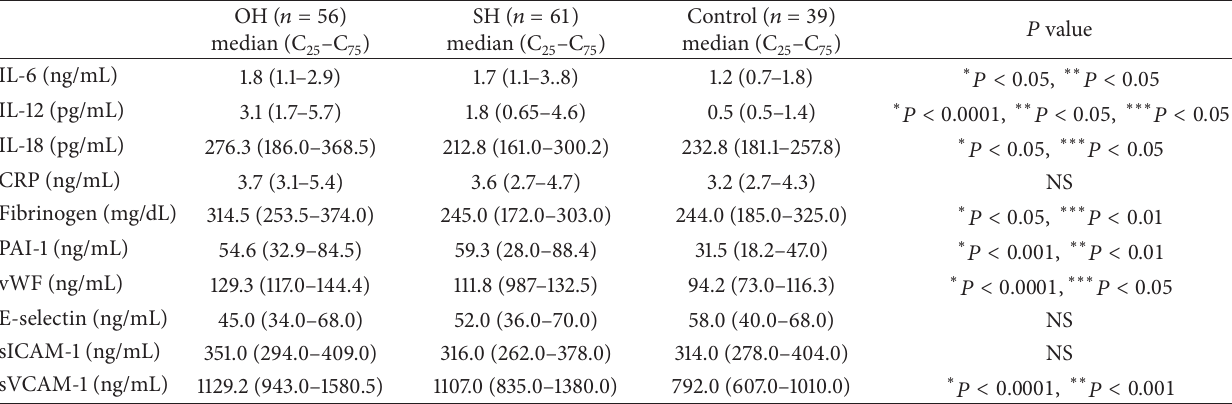
Table 2: Selected markers of inflammation and endothelial dysfunction in the patients with overt (OH) and subclinical hyperthyroidism (SH) and in the control group.